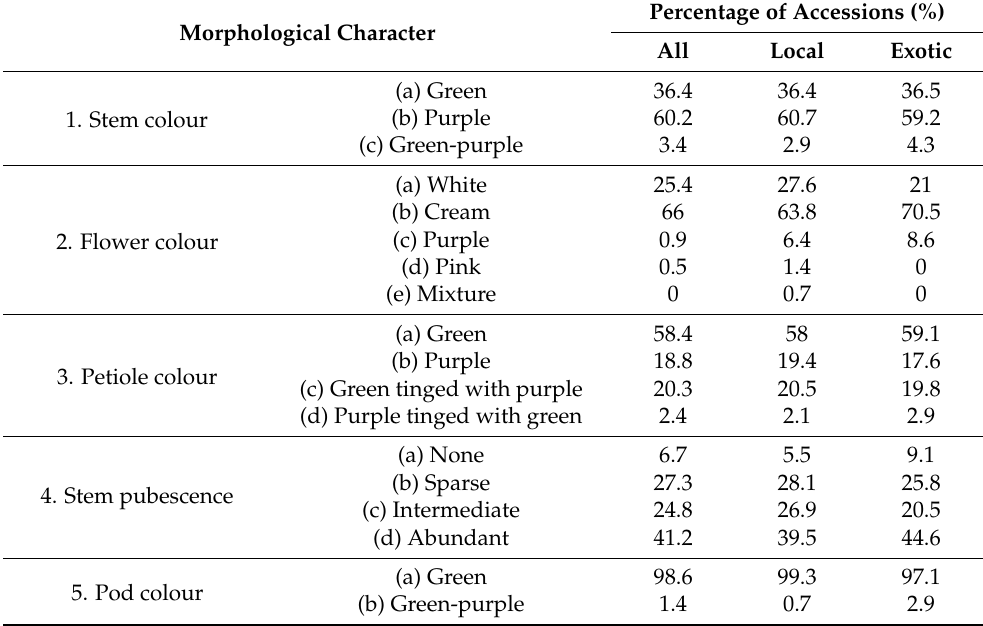
Table 2. Qualitative morphological characters of the local and exotic spider plant accessions that were used in the